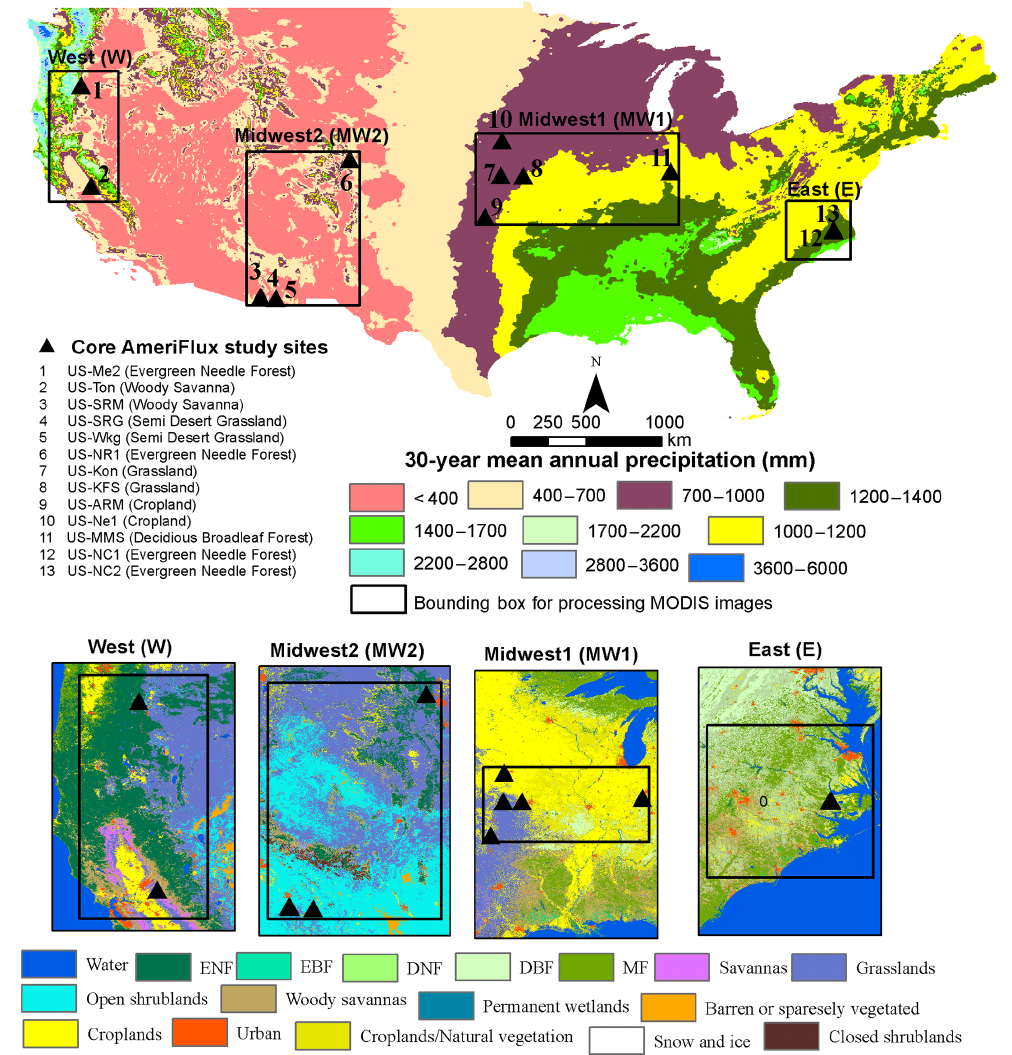
Figure 2. Distribution of core AmeriFlux sites (13) used in this study shown over 30-year (1980–2010) mean annual precipitation of the US and the processing grids (MODIS subsets) used to estimate regional-scale ET from MODIS datasets. MODIS land cover maps for each processing grid represents the year 2013 and shows IGBP level 1 classes. EBF, DNF, and MF represent evergreen broadleaf forest, deciduous needle forest, and mixed forest,